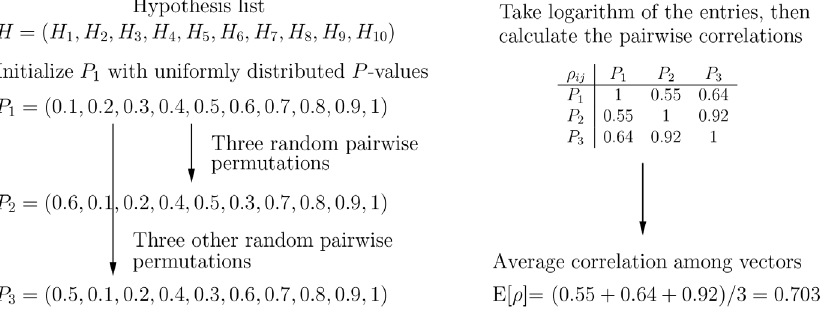
Figure 1. Example workflow of generating correlated P -values and pairwise correlations. In this example figure, K is 10 , the number of P - value vectors is m ~ 3 , the number of pairwise permutations r ~ 3 , and the perturbations d ( i ) s are set to zero for clarity and simplicity. The resulting are displayed in a symmetric matrix form. pairwise correlations by using { ln P j ( i ) in place of x H i , j